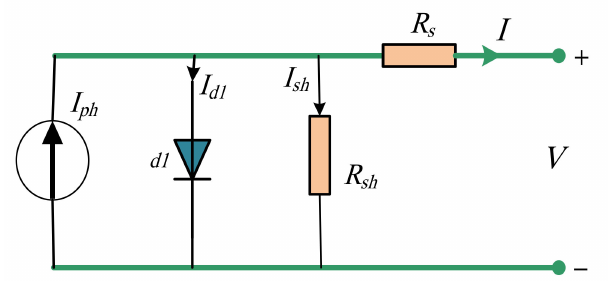
Figure 1. Single diode model (SDM) equivalent circuit.